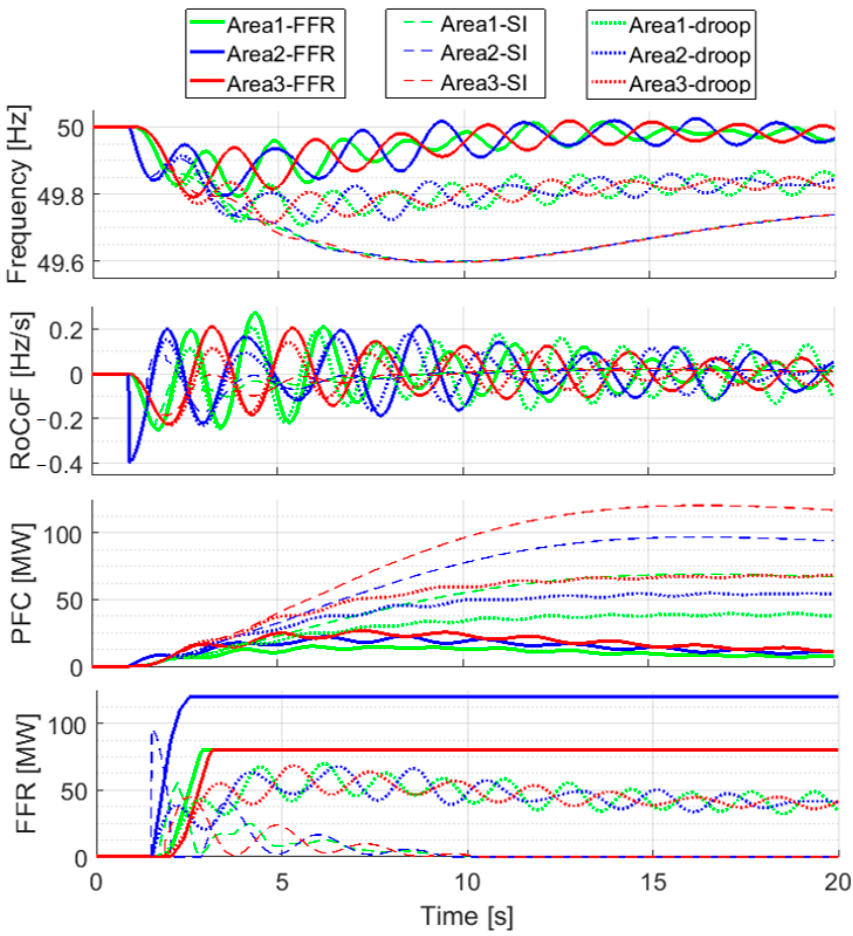
Figure 13. Three-area test system response in the case of a disturbance in Area2—Strong grid—Case 1.1. The system response in the case when areas are not equally distant is shown in Figure 15. The RoCoF was the largest in Area2 with a value of 0.400 Hz/s. Area1 and